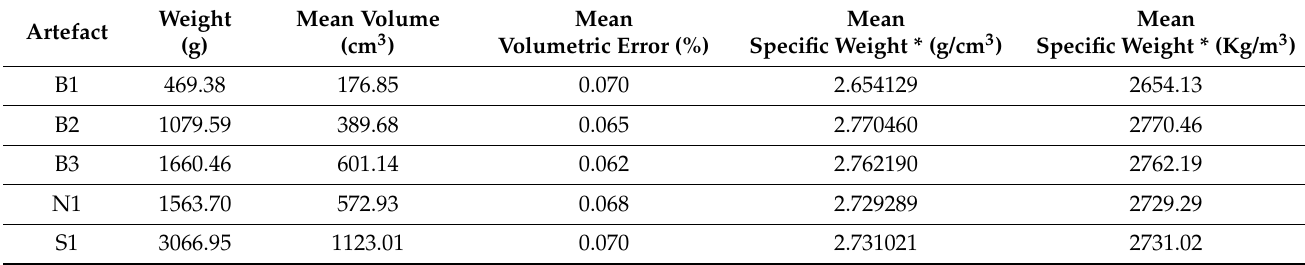
Table 8. Characteristics of worked surfaces and volume variation of the 3D archaeological artefacts reconstructed in RC. Artefact